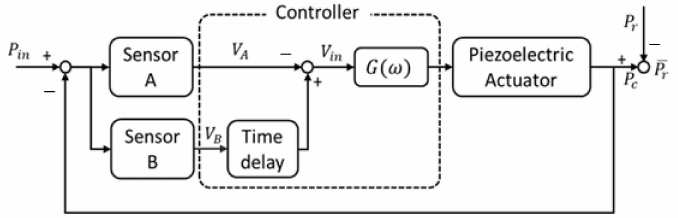
Figure 9. Block diagram of the proposed reduction